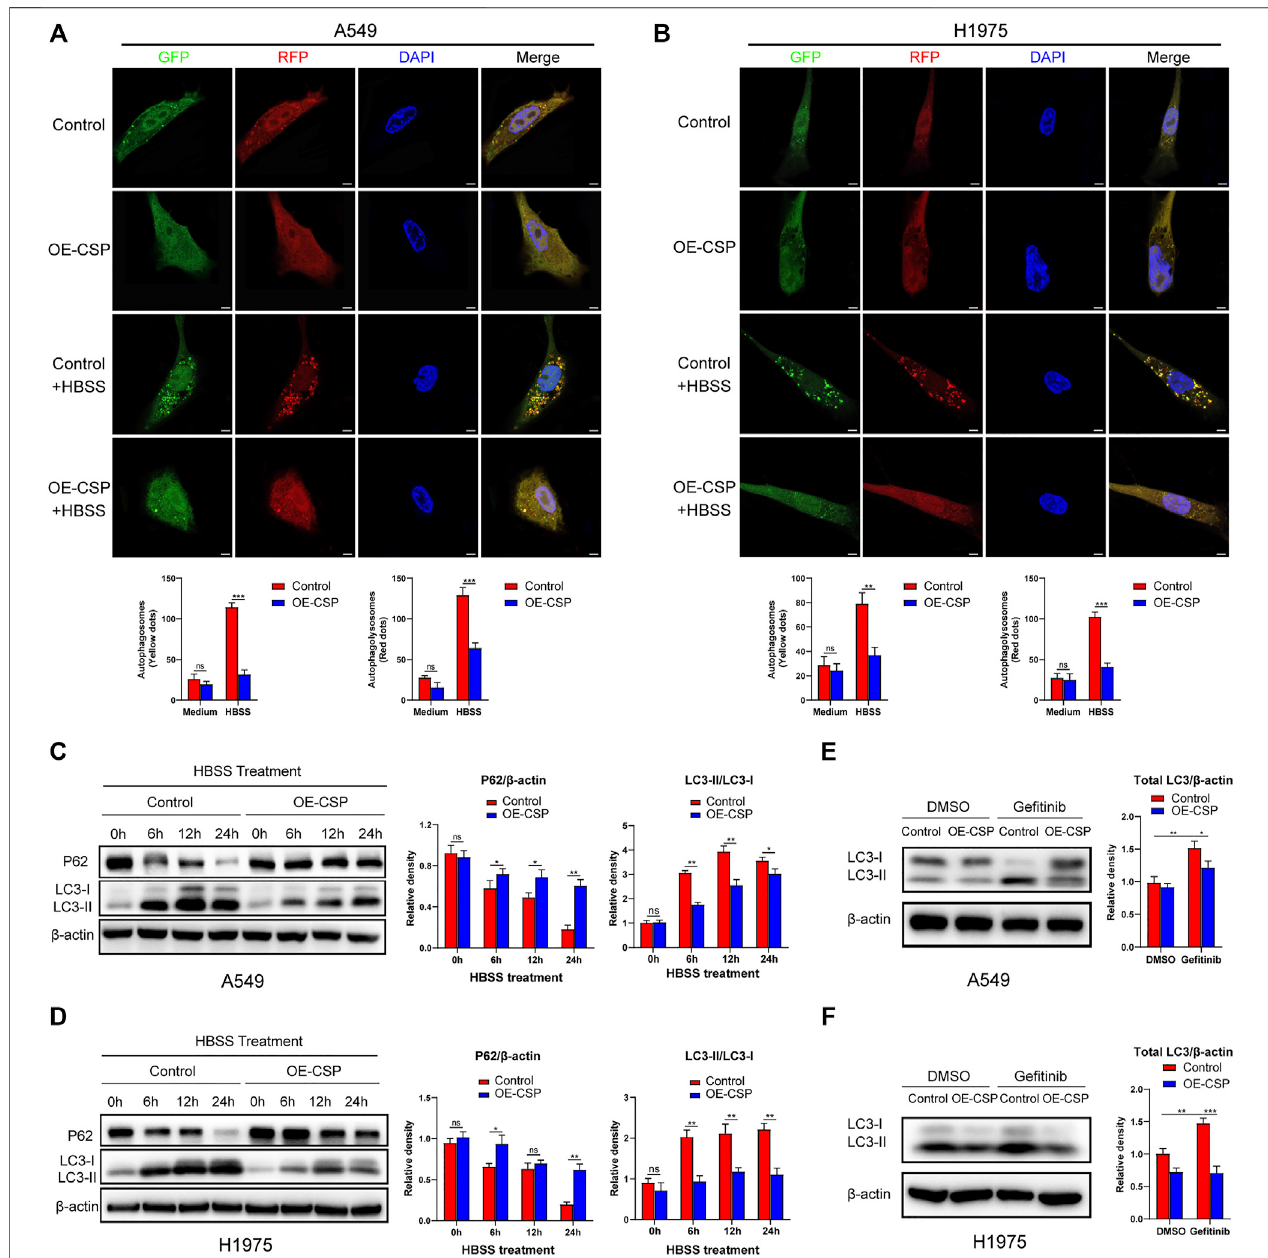
FIGURE4| OverexpressionofCSPinhibited cell autophagy both invivoand invitro .Controland OE-CSP A549 (A) and H1975 (B) cells(1×10 5 )weretransfected with GFP/RFP-LC3B adenovirus and treated with HBSS for 24 h. Fluorescence was then detected using an immuno fl uorescence method. Representative images for immuno fl uorescence ( up ) and statistical histograms ( down ). The puncta of GFP-LC3B and RFP-LC3B were counted using ImageJ software. Scale bar, 5 μ m. The protein level of LC3B and P62 in A549 (C) and H1975 (D) cells was detected using western blotting after they had been treated with HBSS for 0, 6, 12, and 24 h. Theautophagy-relatedproteinLC3BwasdetectedaftercontrolandOE-CSPA549 (E) andH1975 (F) cellsweretreatedwithge fi tinib.TherelativedensityofLC3I/II,total LC3 and P62wasexamined using ImageJ software. Representativeimagesfor western blotting ( left )and statistical histograms ( right ). (G) Expression ofLC3B protein in A549 and H1975 tumor tissues after treatment with ge fi tinib was measured by immunohistochemistry. Representative images for IHC ( left ) and statistical histograms ( right ). Scale bar, 50 μ m, n = 21. Data are shown as the mean ± standard deviation of three independent experiments in vitro (ns, not statistically signi fi cant, * p < 0.05, ** p < 0.01, and *** p < 0.001). HBSS, Hank ’ s balanced salt solution.